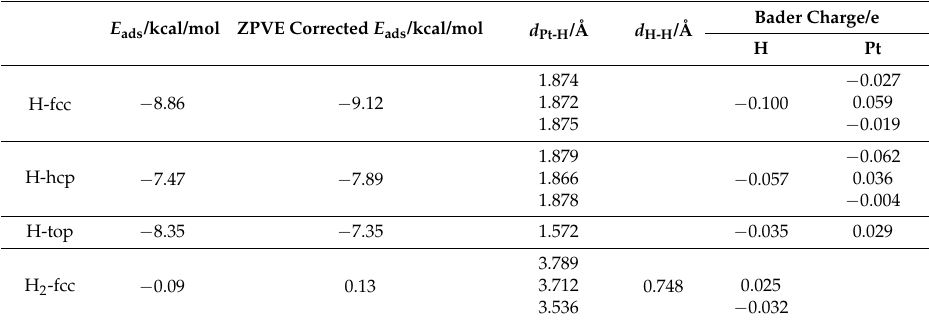
Figure 1. Structures of H(a) and H 2 on Pt(111). The dark blue and white balls represent Pt and H atoms. Table 1. Parameters of H(a) and H 2 on Pt(111).